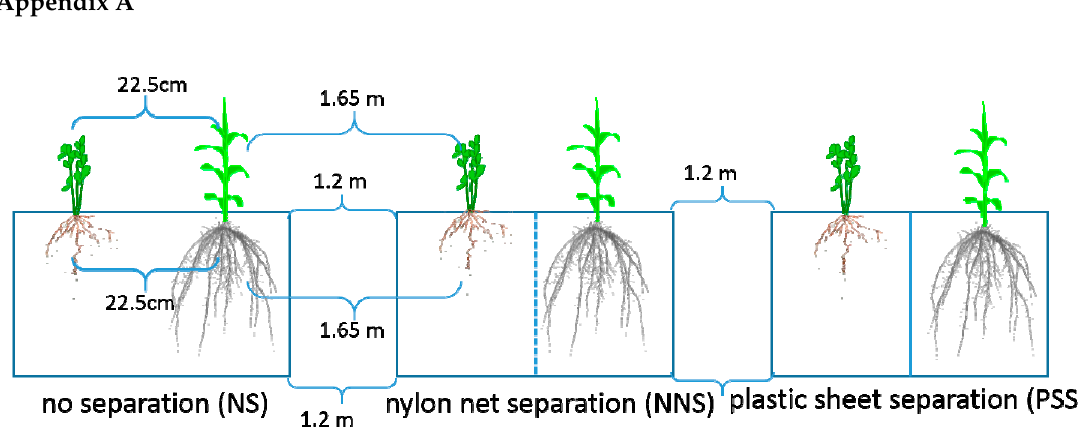
Figure A1. Schematic diagram of the maize / alfalfa intercropping pot experiment.